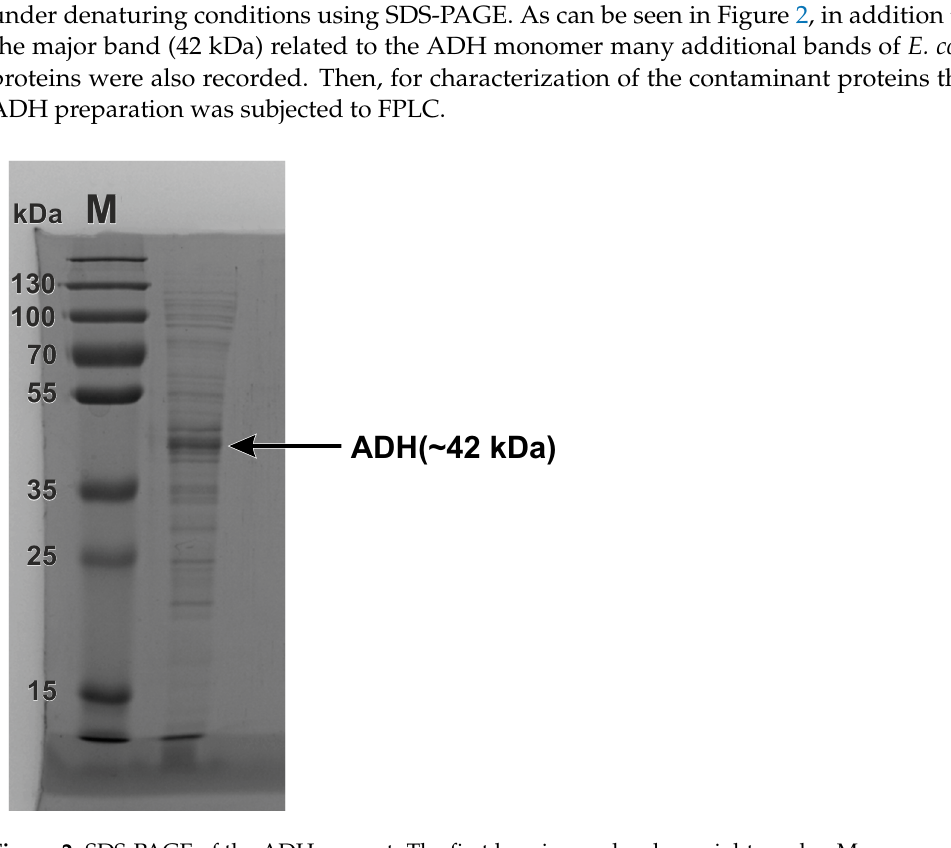
Figure 2. SDS-PAGE of the ADH reagent. The first lane is a molecular weight marker M. The recorded chromatogram of the ADH reagent is shown in Figure 3 where vertical pink dash lines denote the boundaries of different protein fractions. Several intensive peaks shown in the chromatogram in Figure 3 indicate the existence of a large number